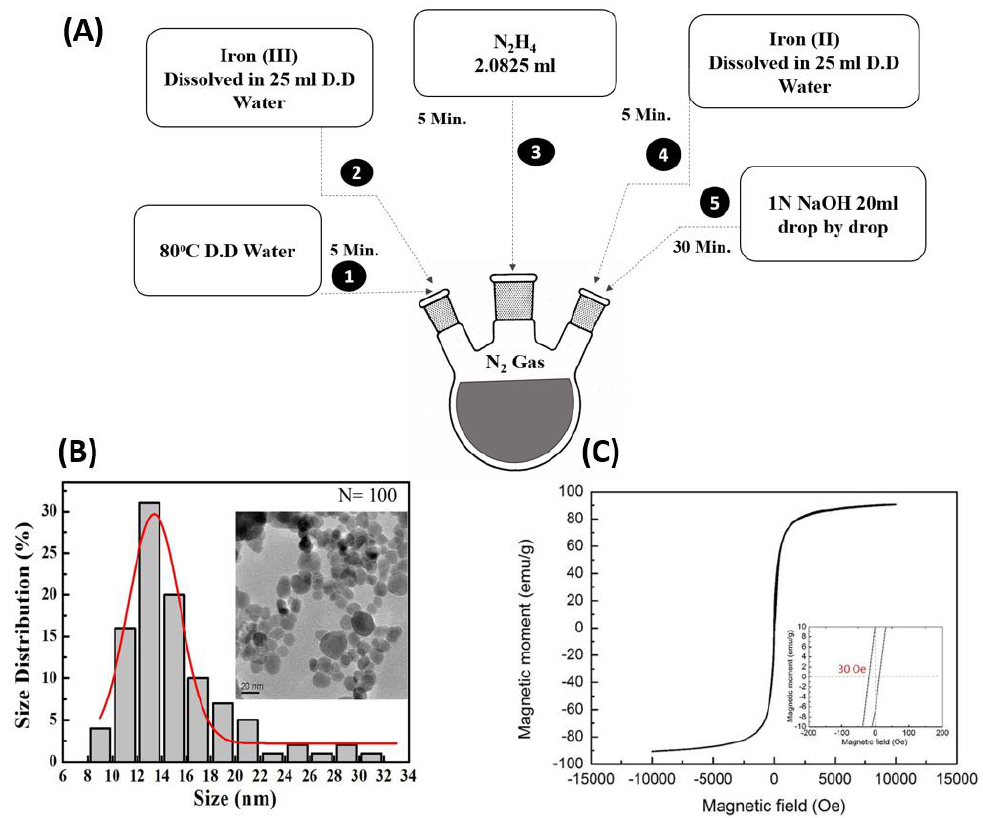
Figure 1. Physical property characterization of Fe 3 O 4 magnetic nanoparticles (MNPs) used in this study. ( A ) Schematic diagram showing the protocol and process for MNPs synthesis. ( B ) Transmission electron microscopy (TEM) examination of the size distribution of the MNPs. Insert: showing the Fe3O4 MNPs particle size and shape under TEM (scale bar = 20 µ m). ( C ) Hysteresis curve of the MNPs measured by superconducting quantum interference device (SQUID) magnetometry. Insert: showing the calculated magnetic field of the synthesized Fe3O4 MNPs.